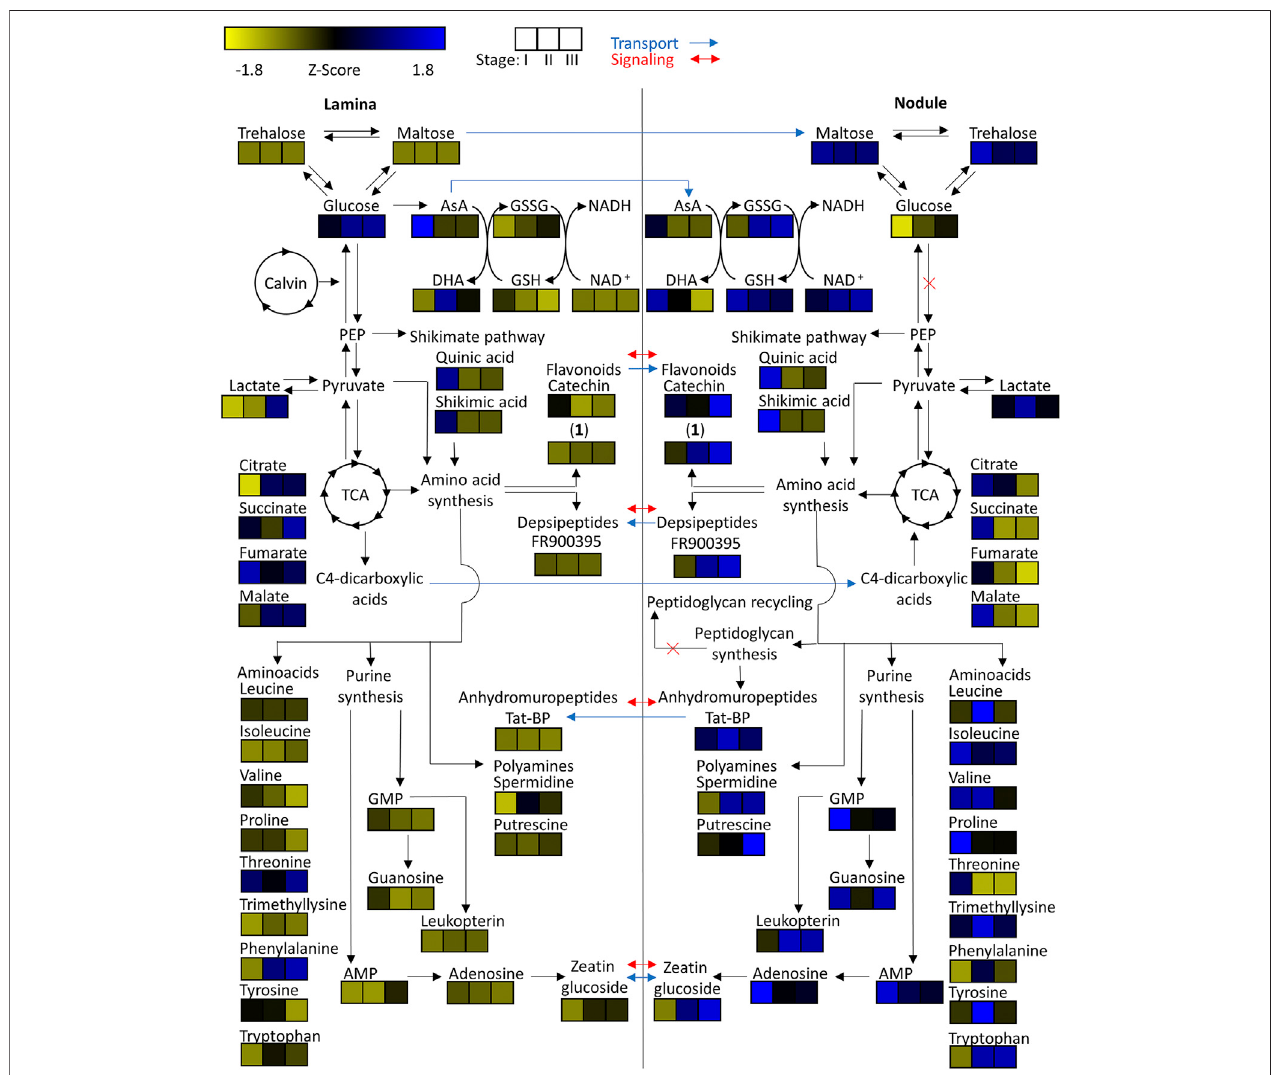
FIGURE7| Heatmap ofz-scored means ofselected m/z featuresof Ardisiacrenata tissue extracts illustratedwithintheir connected metabolic pathways. Possible metabolite transport is denoted by a blue arrow and possible signaling is denoted by a red arrow.